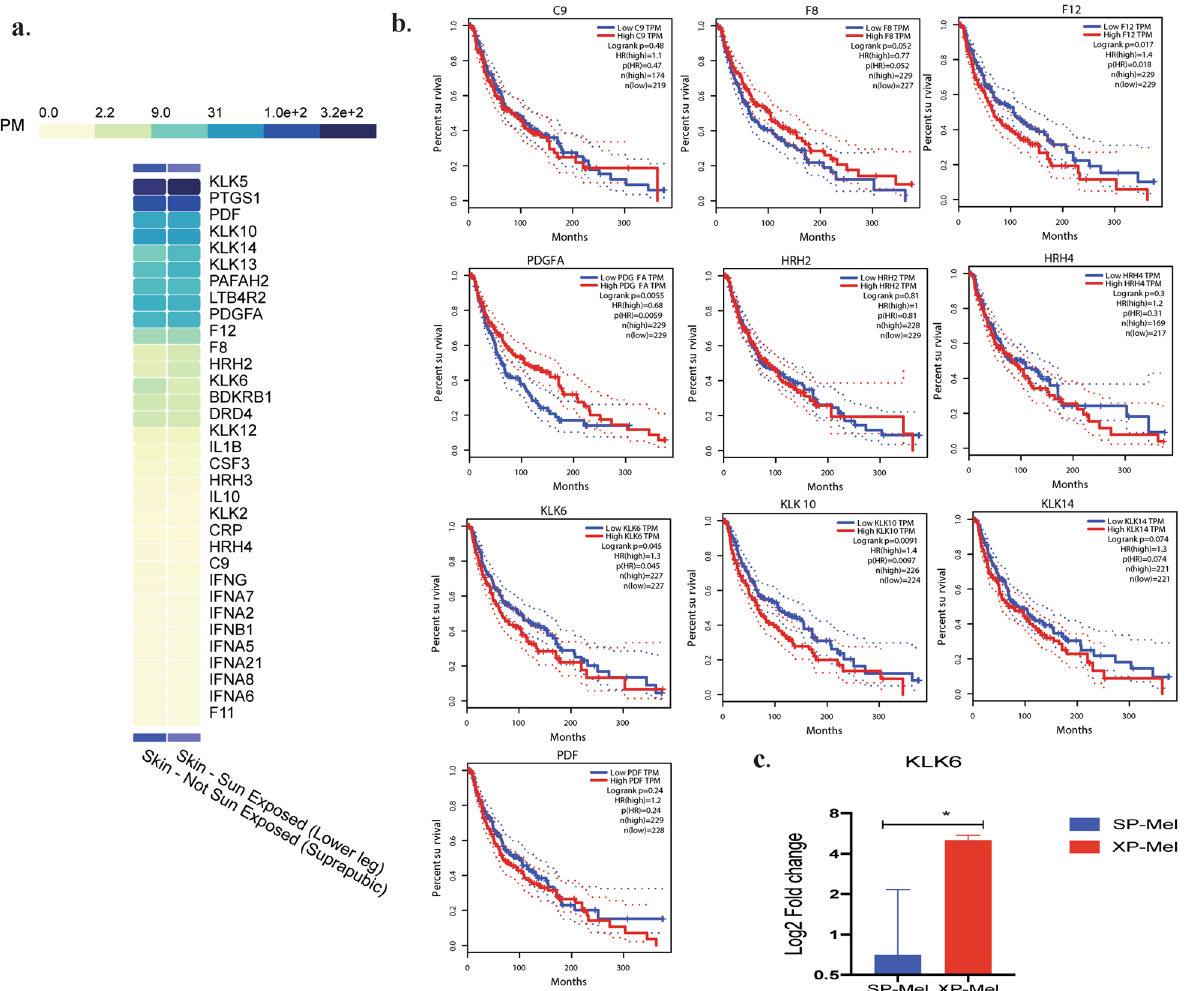
Figure 4. Exploration of the 34 specific inflammatory genes in XP-Mel tumors in GTEx and GEPIA databases: ( a ) Heatmap depicting the altered inflammatory genes via GTEx platform in healthy and sun-exposed skin samples; results are expressed in TPM (the number of Transcripts Per million Readings). ( b ) Overall survival outcomes of patients with sporadic melanoma with low and high gene expression of C9, F8, F12, PDGFA, HRH2, HRH4, KLK6, KLK10, KLK14, and PDF . Kaplan–Meier curves are plotted using the GEPIA online Tool, 95% confidence intervals are shown ( c ) KLK6 gene expression in SP-Mel and XP-Mel, normalized expression from the PCR array results. Hazard ratios (HR); (* p -value <